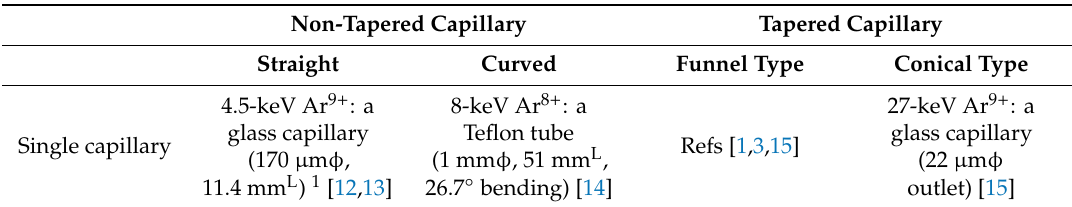
Table 2. Example experiments of various single capillaries.